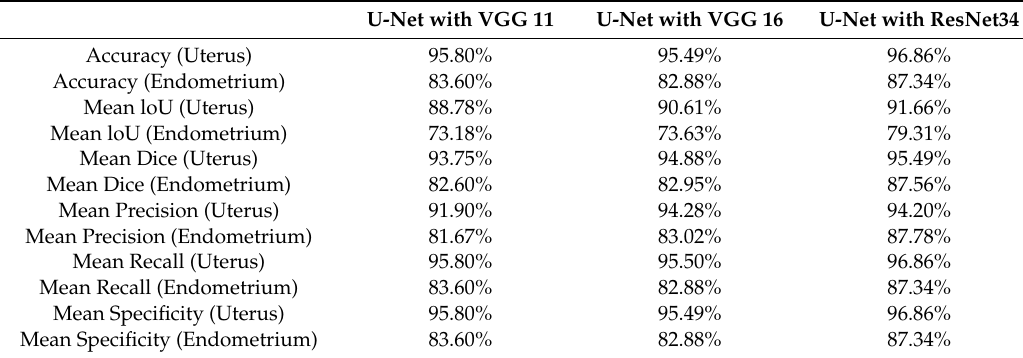
Table A2. Verification summary of the performance of three AI models on T2w using the validation dataset. The parameters of accuracy, sensitivity and specificity for both uterus and endometrium are shown.